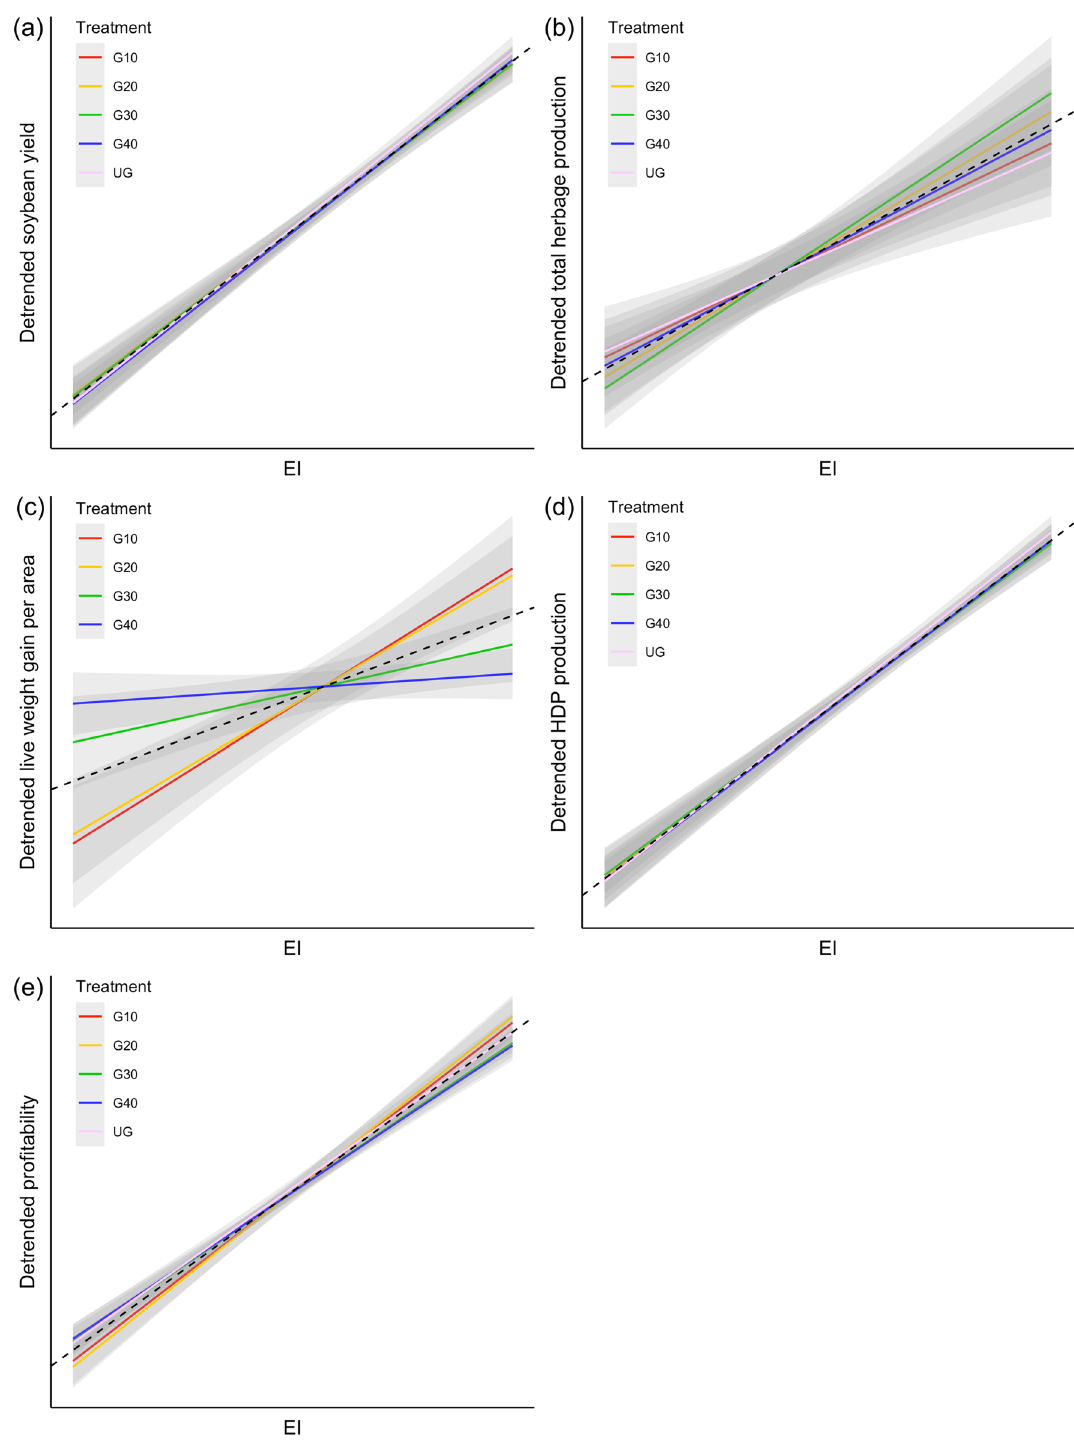
Figure 1. Yield stability of ( a ) soybean yield (kg grain ha −1 ), ( b ) total herbage production (kg dry matter ha −1 ), ( c ) animal live weight (LW) gain (kg LW ha −1 ), ( d ) human-digestible protein (HDP) production (kg HDP ha −1 ) and ( e ) profitability (USD ha −1 ) of soybean systems integrated with different levels of cattle grazing during the winter period. Environmental index (EI) was calculated as the yearly mean detrended yield. Dashed lines are the regression of detrended yields against the EI without treatment effects. G10: intense grazing (10 cm sward height); G20: moderate grazing (20 cm sward height); G30: moderate-light grazing (30 cm sward height); G40: light grazing (40 cm sward height); UG: ungrazed cover crop. Smaller slopes indicate greater yield